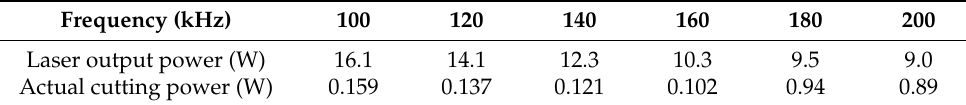
Figure 1. Experimental setup of PI film cutting process. Table 1. Correspondent relationship between input PRF and output power.